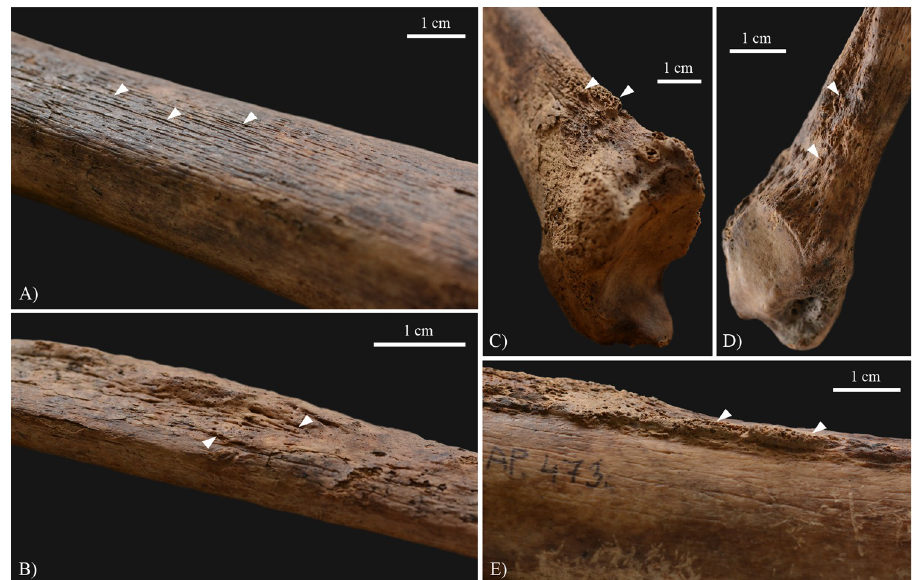
Fig 8. Slight surface pitting and longitudinally striated subperiosteal new bone formations (white arrows) on the shaft of the right A) tibia (medial surface) and B) fibula (posterior surface) of KK61. Exostoses (white arrows) on the distal part of the right C) tibia (lateral surface), D) fibula (medial surface), and E) femur (posterior surface) of